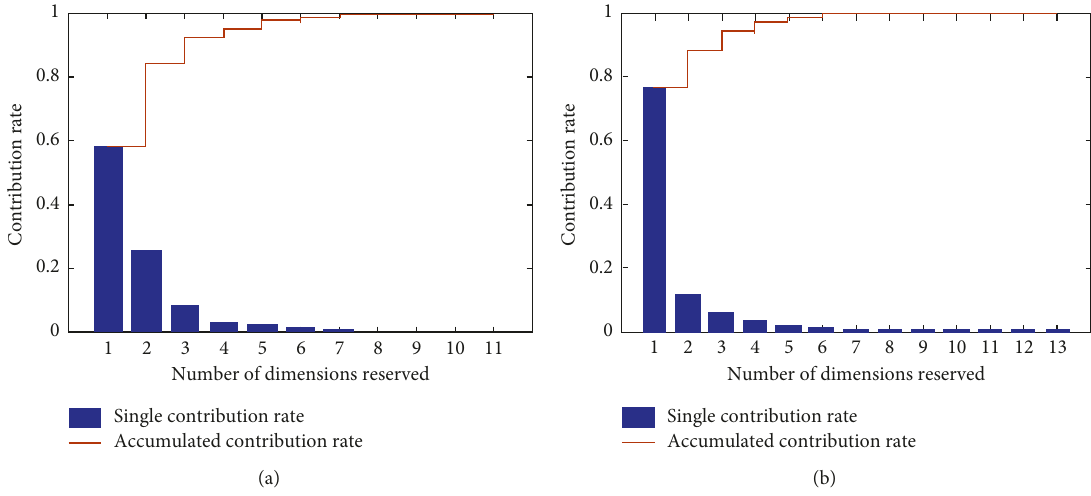
Figure 5: Single and accumulated variance contribution rate after PCA processing: (a) behavioral features; (b) physiological